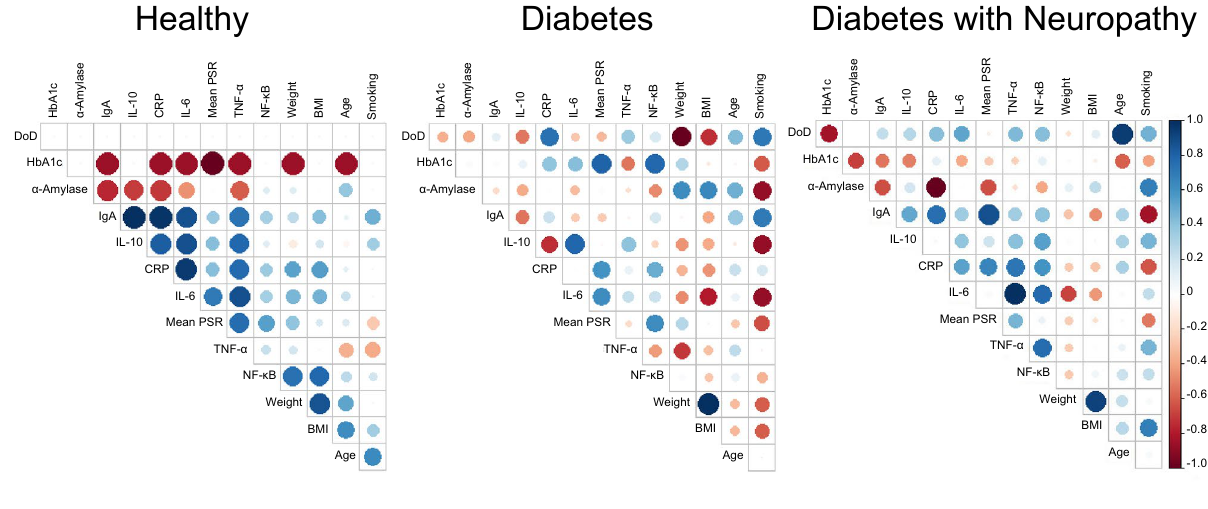
Figure 3. The heatmap patterns with spearman correlation coefficient. Each row and column show biomarkers and clinical parameters. The colors represent coefficient values (blue means positive correlation and red means negative), and the circle sizes are scaled by the correlation